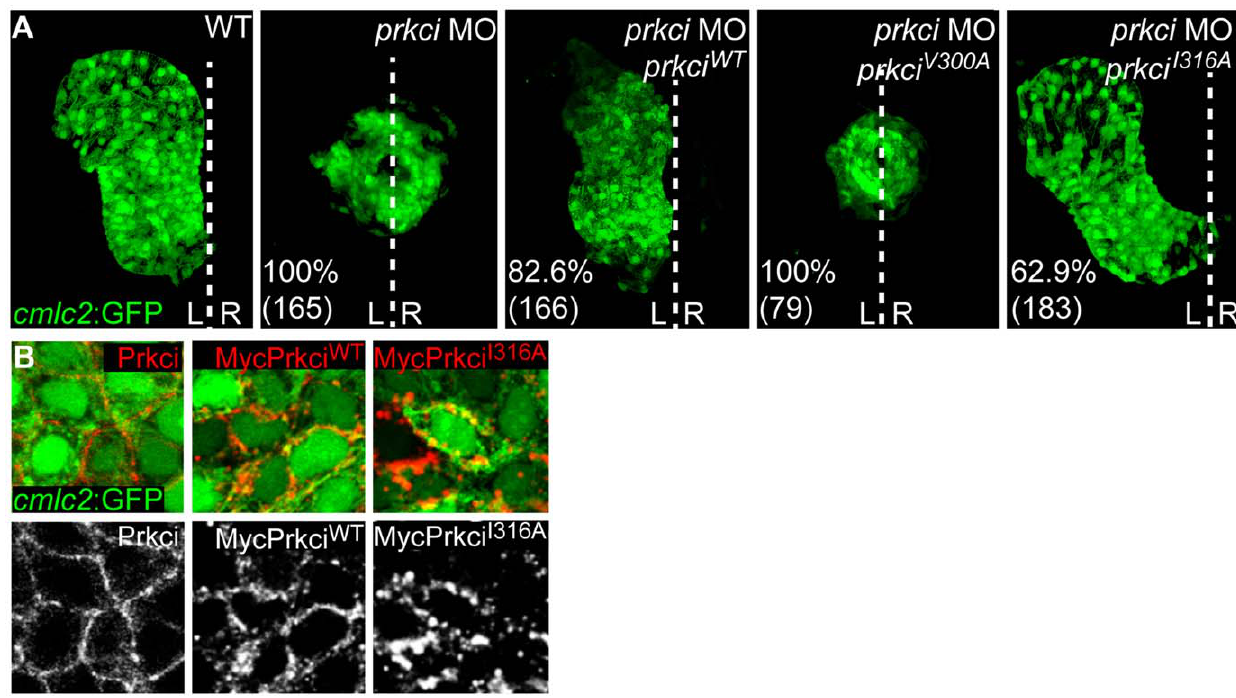
Figure 2. Mutant Prkci I316A has normal invivo biological activity. ( A ) Reconstruction of confocal Z-stack sections of embryonic hearts at 28– 30 hpf. Transgenic Tg[ cmlc2:GFP ] twu34 one-cell stage embryos were injected with prkci MO alone or together with mRNA encoding Prkci WT or analog- sensitive mutant forms of Prkci. Whereas the wild-type heart elongates into a heart tube and towards the left during cardiac jogging, heart development arrests at the cone stage and the heart remains at the embryonic midline in prkci morphants. In functional rescue experiments, injection of prkci MO together with mRNA encoding HisMyc-Prkci WT or Prkci I316A rescues heart tube elongation. In comparison, the analog-sensitive mutant form Prkci V300A fails to rescue heart tube formation in prkci morphants. Percentiles indicate the occurrence of the most common phenotype as depicted in the images and numbers show the total of embryos tested. White dotted line indicates the embryonic midline. L, left; R, right. ( B ) Membrane localization of endogenous Prkci detected with an anti-Prkci antibody and exogenous Prkci WT or Prkci I316A in zebrafish cardiomyocytes detected with an anti-Myc antibody. Images are confocal reconstructions of single Z-stack sections of embryonic hearts marked by the transgenic reporter Tg[ cmlc2:GFP ] twu34 at 28–30 hpf. Expression of exogenous HisMyc-Prkci WT or HisMyc-Prkci I316A in cardiomyocytes reveals that both recombinant proteins localize to the cell membrane.